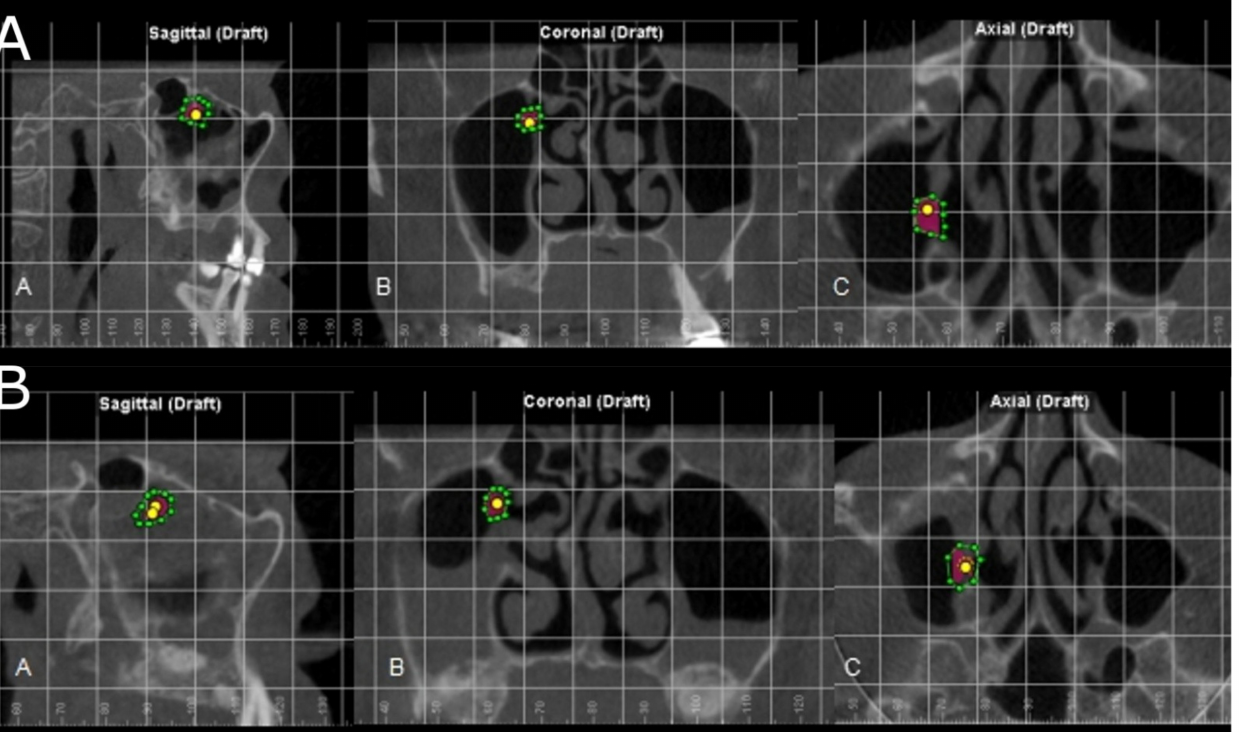
Figure 4. ( A ) Preoperative and ( B ) postoperative assessment of the position and permeability of the maxillary sinus ostium in the axial, coronal, and sagittal